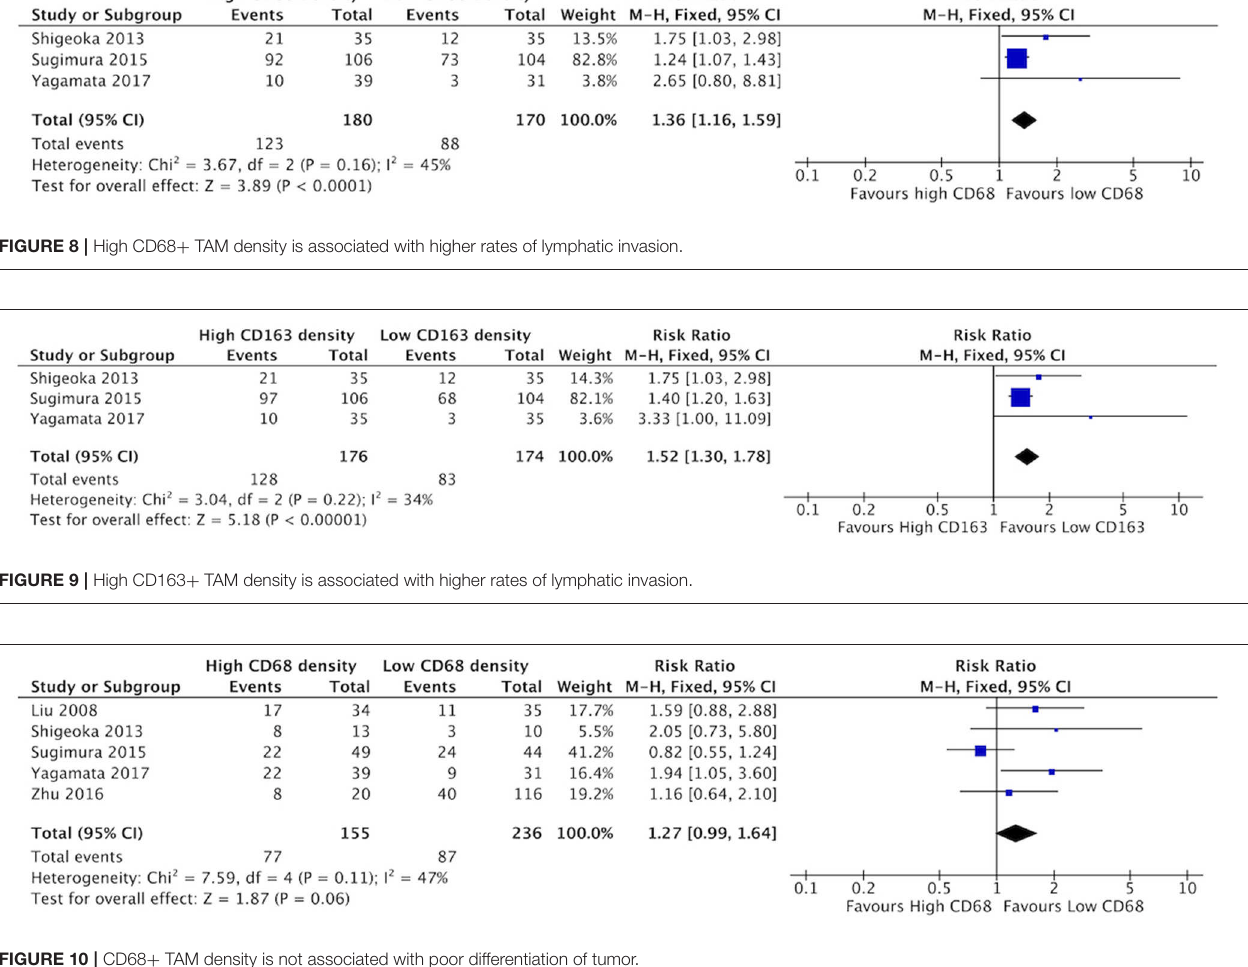
FIGURE 10 | CD68 + TAM density is not associated with poor differentiation of tumor.